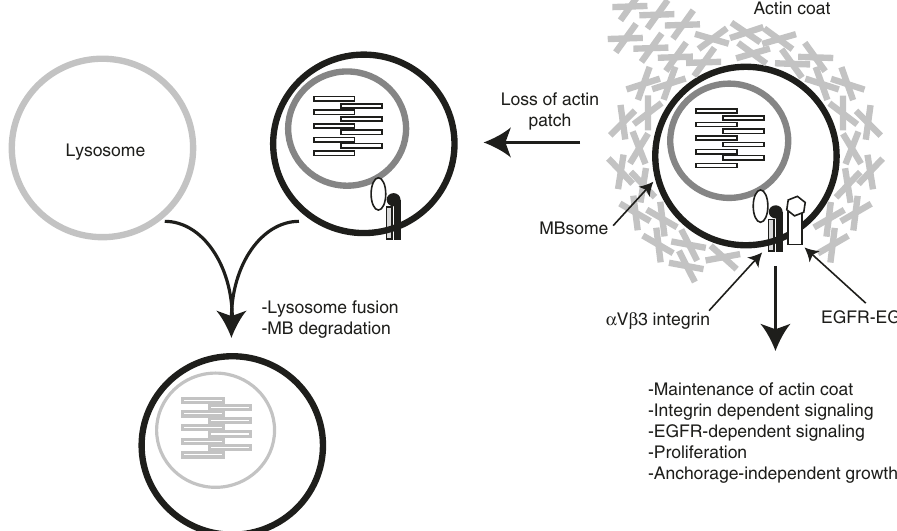
Fig. 8 Schematic representation of the proposed MBsome regulation and